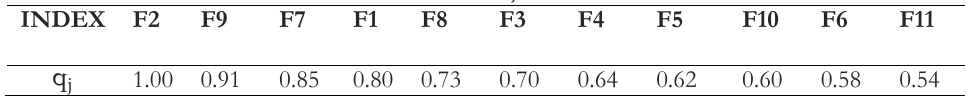
Table 11. Amounts of 𝐪